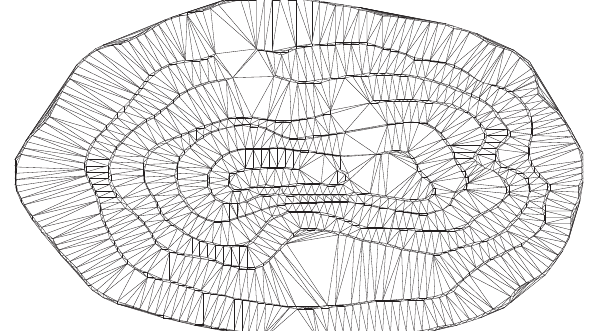
Figure 7: Display of Bowyer–Watson triangulation.